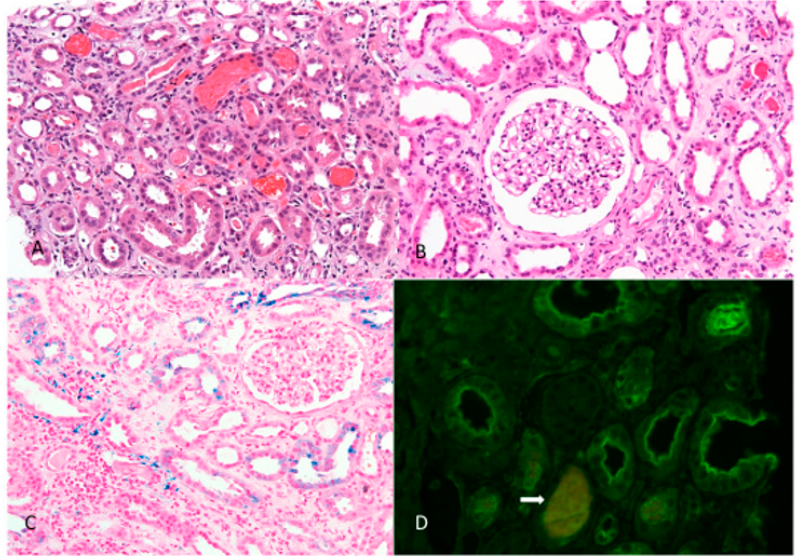
Figure 2. Light microscopy kidney biopsy findings: ( A ) Signs of acute tubular injury, occlusive red blood cell casts in the tubules, and diffuse interstitial edema (hematoxylin and eosin stain; original magnification × 200). ( B ) Mild glomerular segmental mesangial proliferation—mild IgA nephropathy and signs of acute tubular injury (hematoxylin and eosin stain; original magnification × 200). ( C ) Hemosiderin intracytoplasmic deposition in tubular epithelial cells (confirmed by Perl’s stain, original magnification × 200). ( D ) Occlusive red blood cell (RBC) casts not containing Tamm Horsfall protein (arrow; original magnification ×